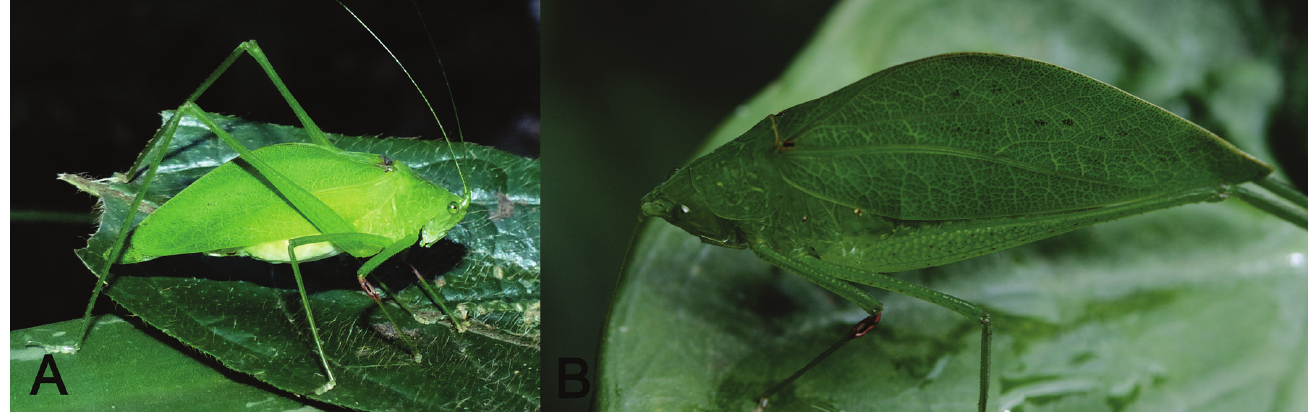
Fig. 1. Lunidia bicercata sp. n. , Uluguru Mountains. A. Male ; B. Female.